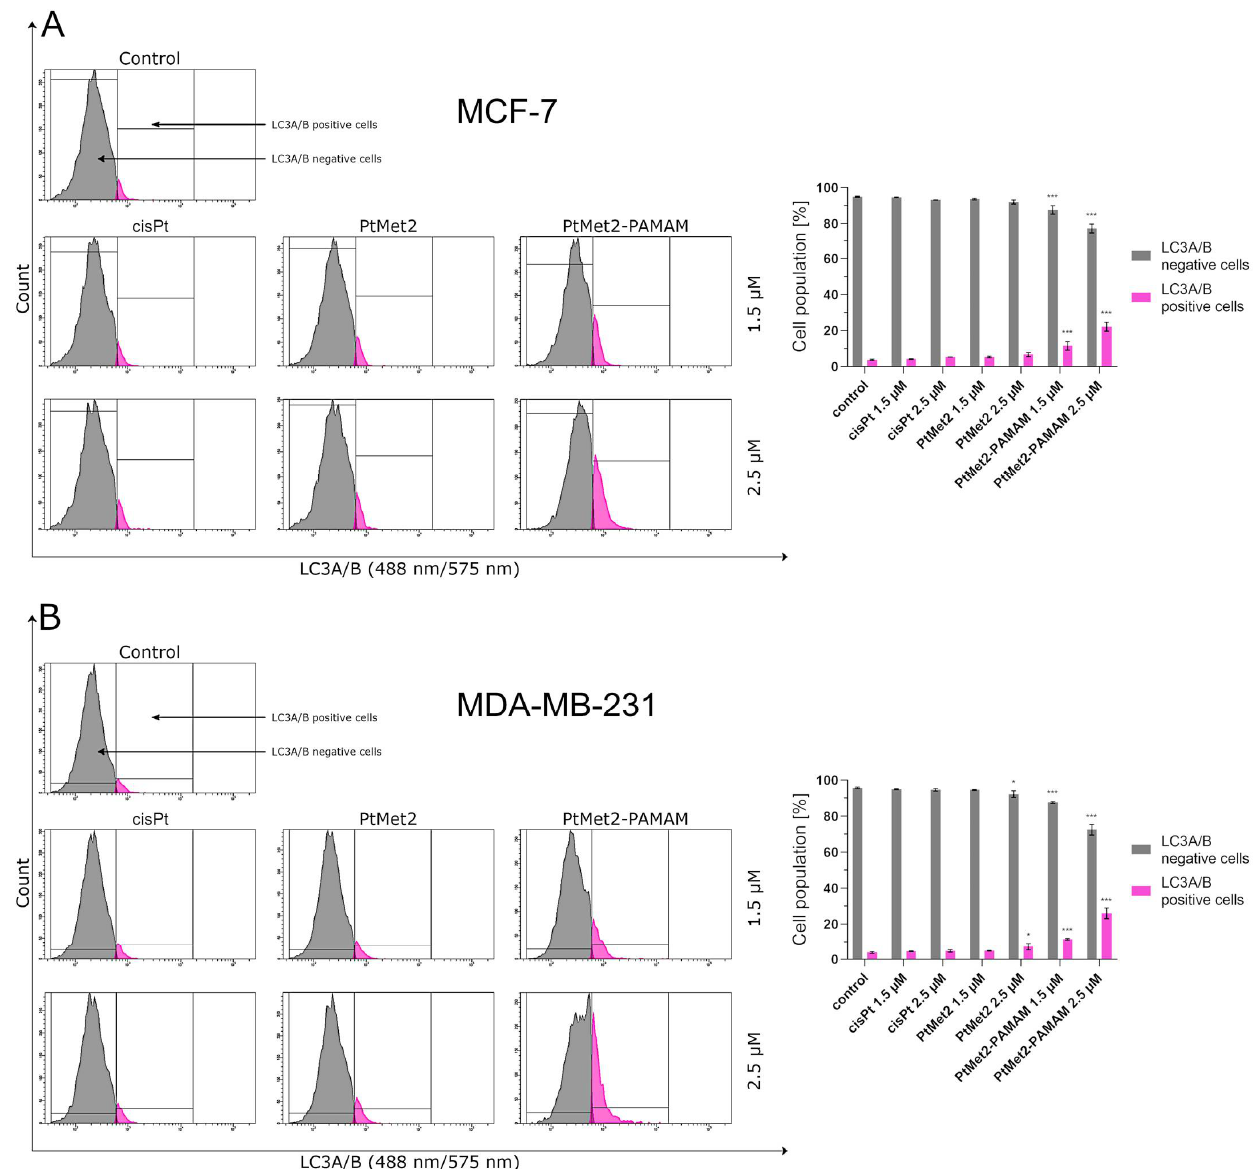
Figure 11. Anti-LC3A/B antibody flow cytometric analysis of MCF-7 ( A ) and MDA-MB-231 breast cancer cells ( B ) (pink color) compared to a negative control cell (gray color) after 24 h of incubation with PtMet2, PtMet2–PAMAM, and cisplatin (1.5 μM and 2.5 μM). Mean percentage values from three independent experiments ( n = 3) done in duplicate are presented. * p < 0.05 vs. control group, *** p < 0.001 vs. control group.